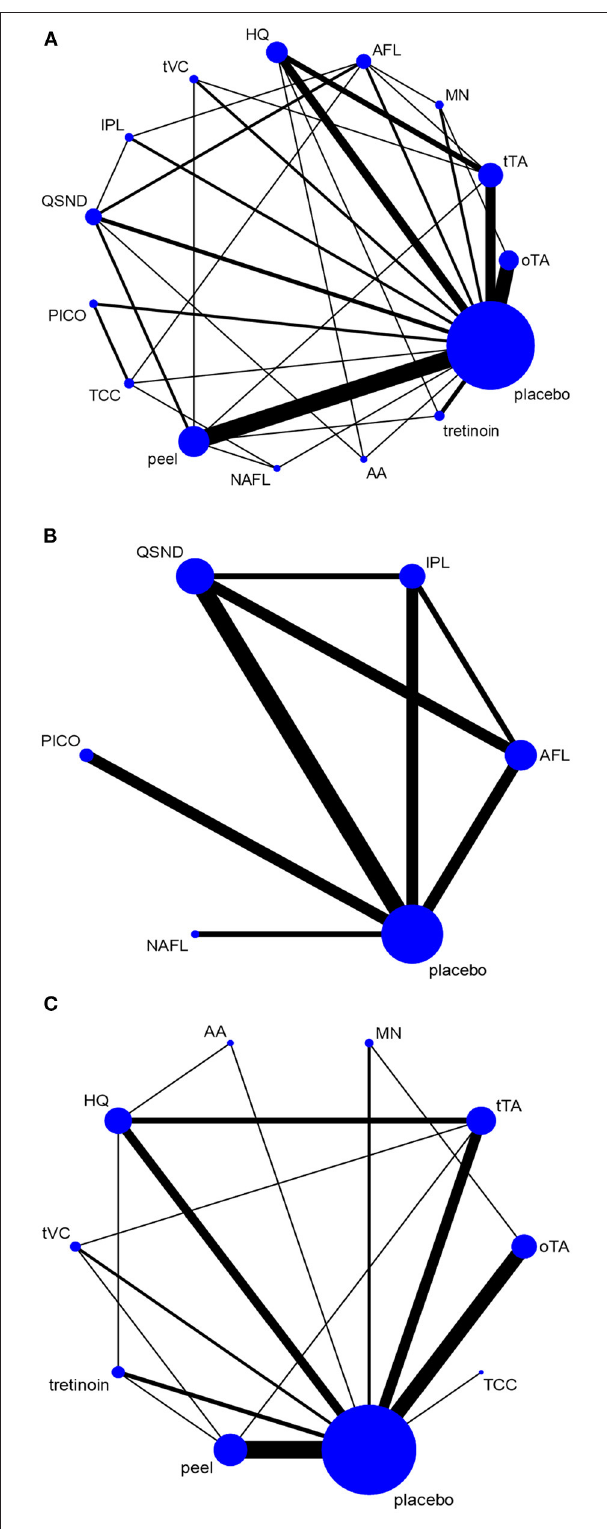
FIGURE 2 | Network graph. The network graph shows the evidence network for all selected interventions. (A) Network graph for all selected interventions; (B) network graph for energy-dependent treatments; and (C) network graph for nonenergy-dependent